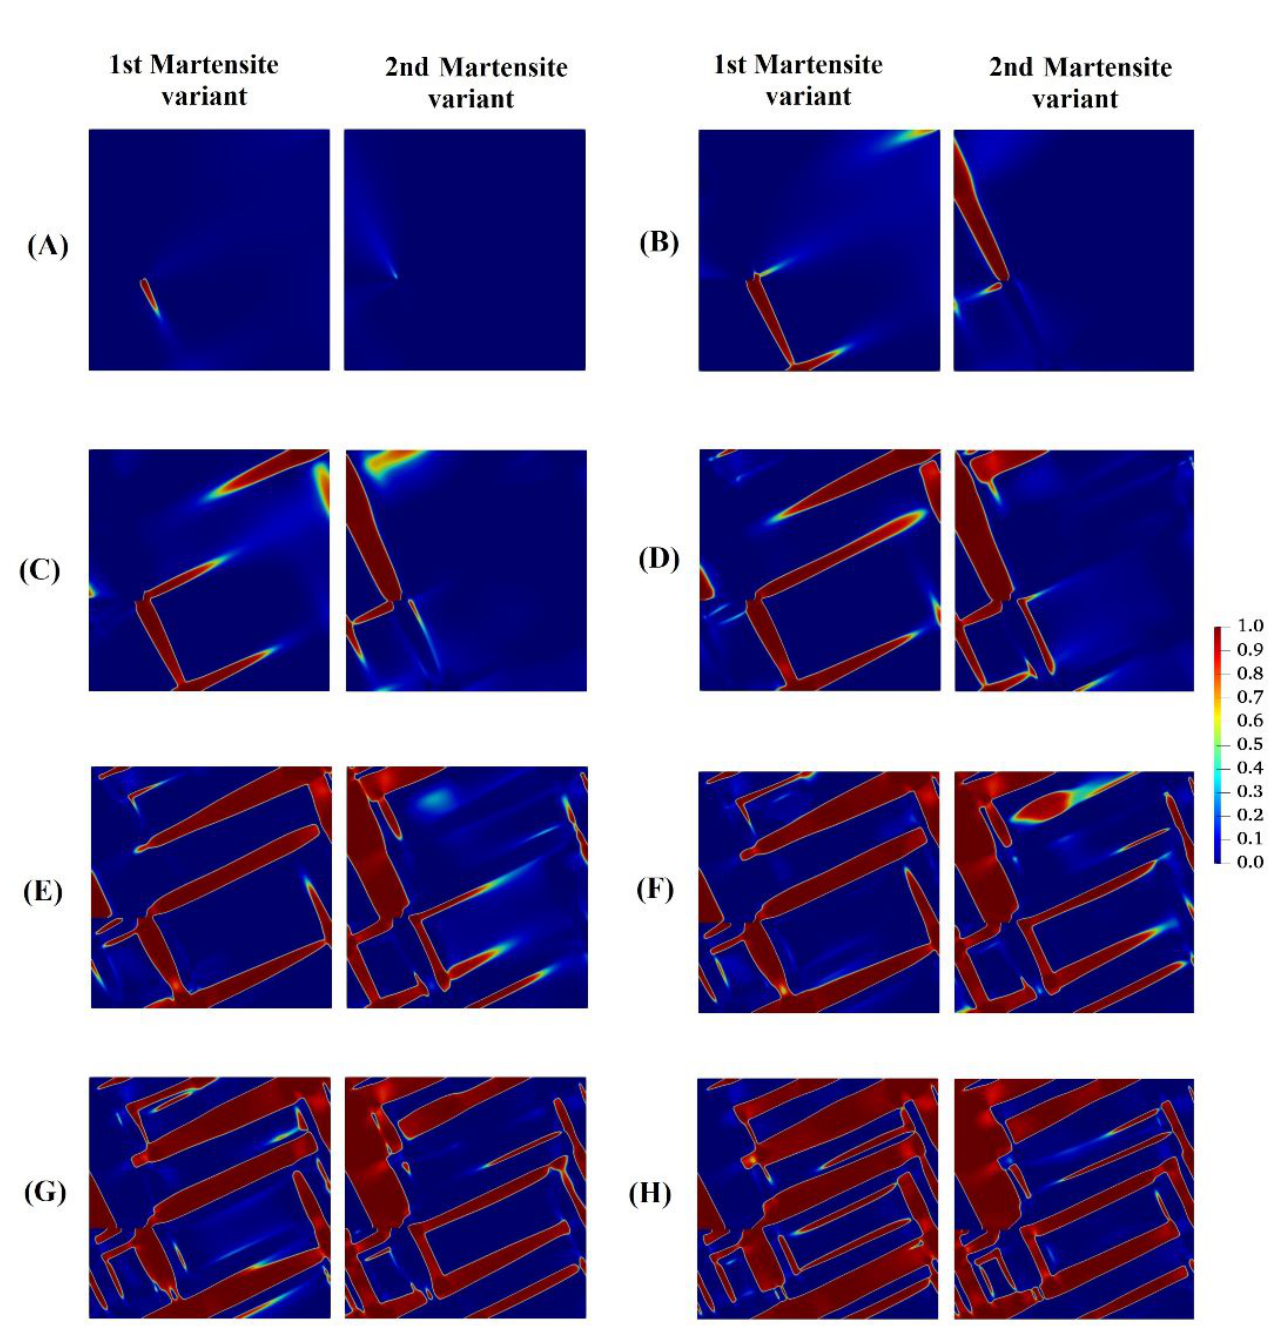
Figure 5. Evolution of two martensite variants prior to crack propagation in austenitic microstructure with crystal lattice orientation of 15°